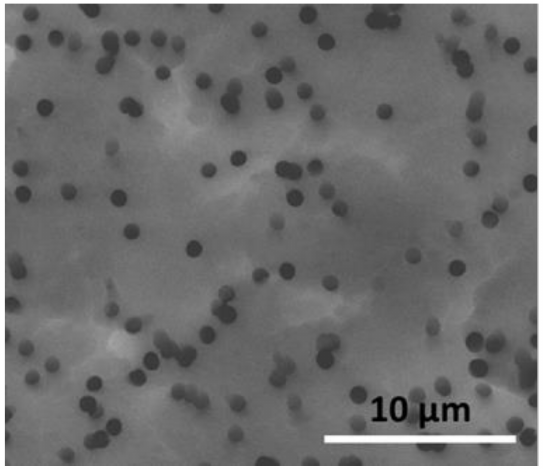
Figure 2. Scanning electron micrograph showing the surface of a Whatman Nuclepore™ track-etched polycarbonate (Hydrophilic) membrane. The average pore size is measured as ca. 1 µ